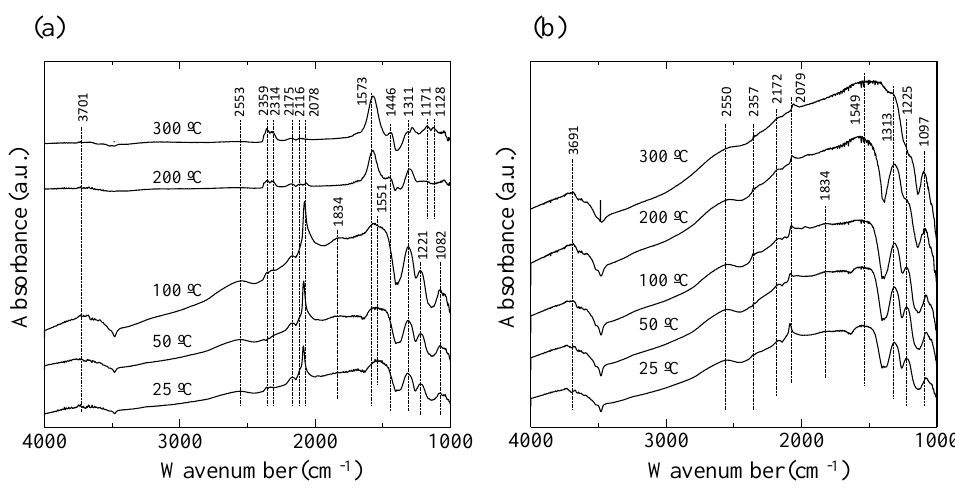
Figure 7. Diffuse reflectance Fourier transform Infrared spectroscopy (DRIFT) spectra of the AuPtPd/SnO 2 catalyst powder at 25–300 °C, in ( a ) 10,000 ppm CO in dry air, and ( b ) 10,000 ppm CO in Ar.